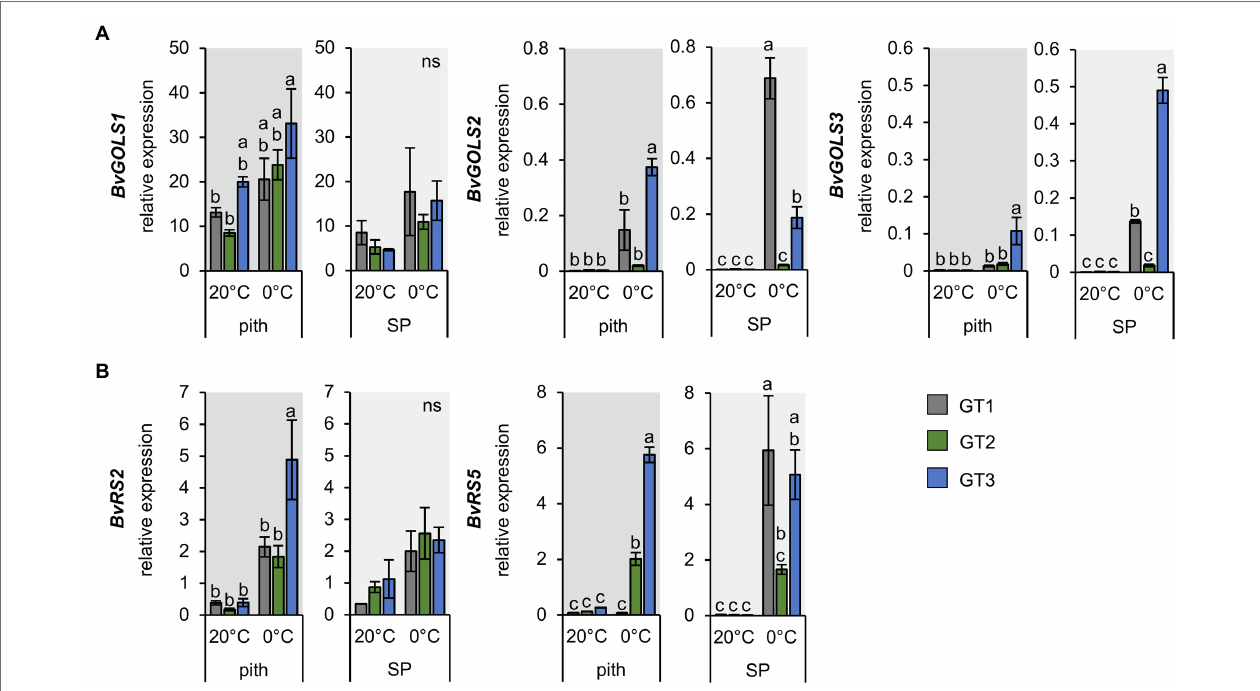
FIGURE 6 | Expression of GOLS and RS isoforms in pith and storage parenchyma samples of three contrasting B. vulgaris cultivars. Relative expression of GOLS (A) and RS isoforms (B) in the pith and storage parenchyma at 20 ° C and freezing treatment at 0 ° C. Bars represent means from three biological replicates ± standard error. Different letters indicate significant differences between genotypes within a tissue according to two-way ANOVA with post-hoc Tukey HSD testing ( p <